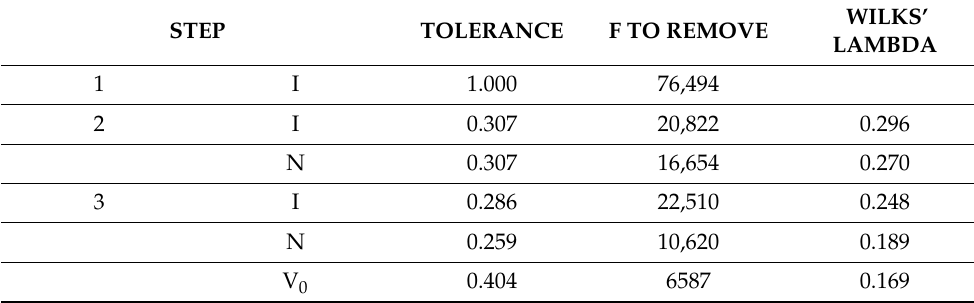
Table 2. Stepwise model of discriminant analysis: variables in the